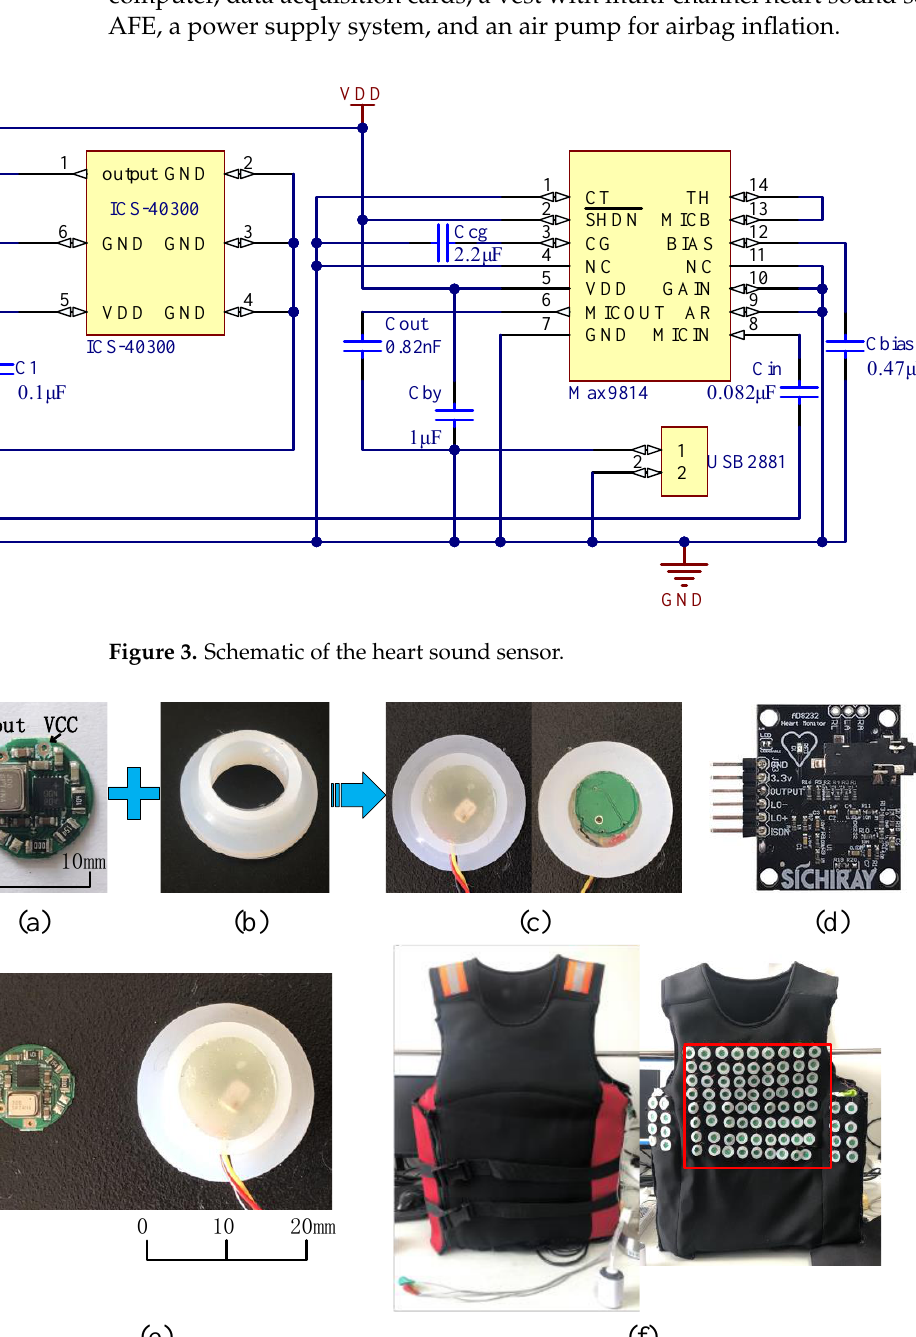
Figure 5. Multi-channel wearable heart sound visualization system. 2.3. Sensor Test The sensor performance test included sensor consistency, frequency response, and SNR. The test was performed in a quiet room of 15 m 2 . The DC power supplied to the